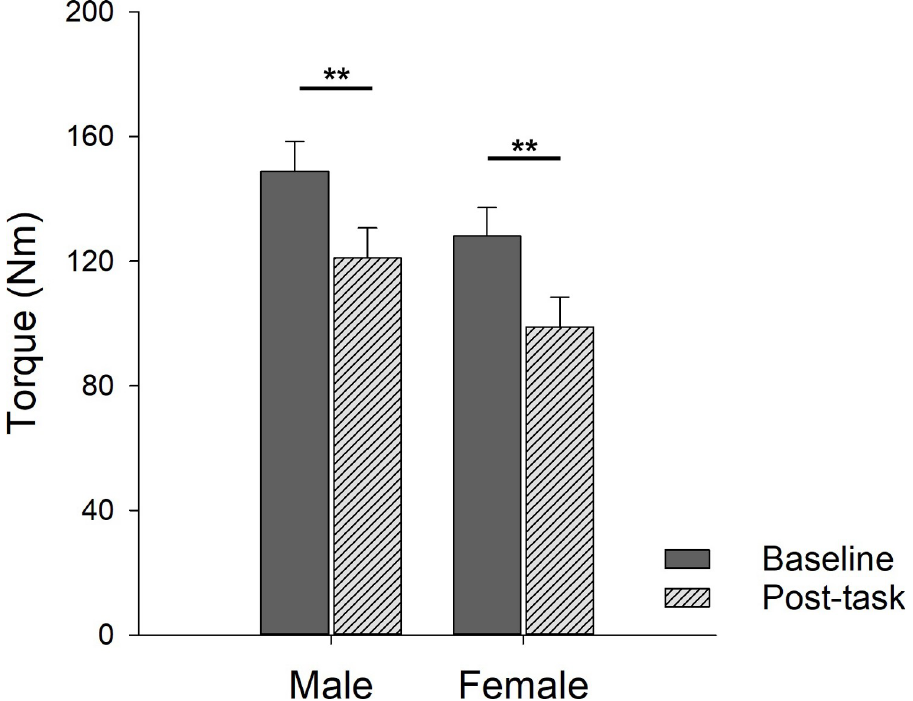
Fig 3. MVIC torque before and after the SLHR in males and females. Torque was reduced following SLHR task for both males (dark gray, 18.6% reduction from baseline) and females (light gray, 22.7% reduction from baseline). �� p <